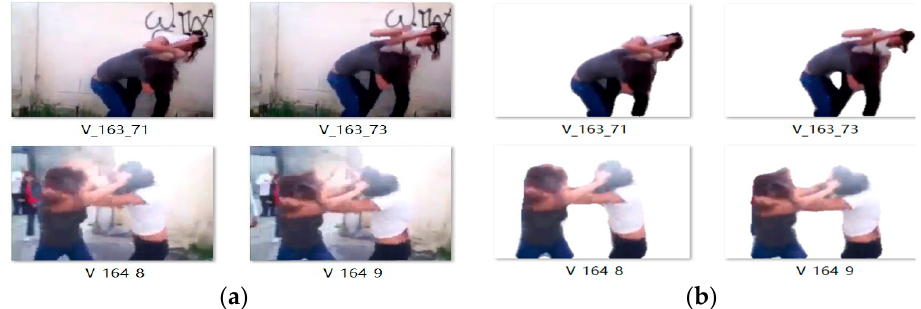
Figure 5. Our dataset. ( a ) Original image, ( b ) Segmented image.